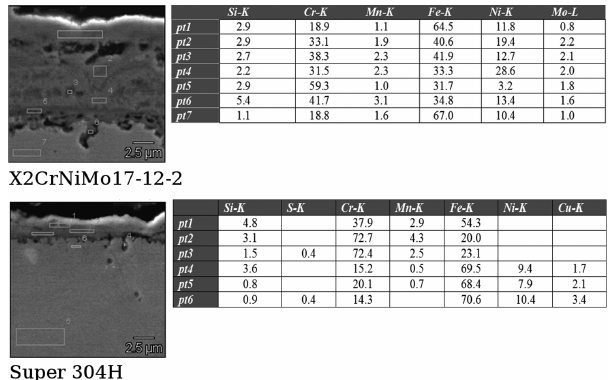
Figure 11: Microphotographs of cross-sections of oxidized steel samples with marked regions in which the EDS analysis has been performed and the results of such analysis (expressed in at.